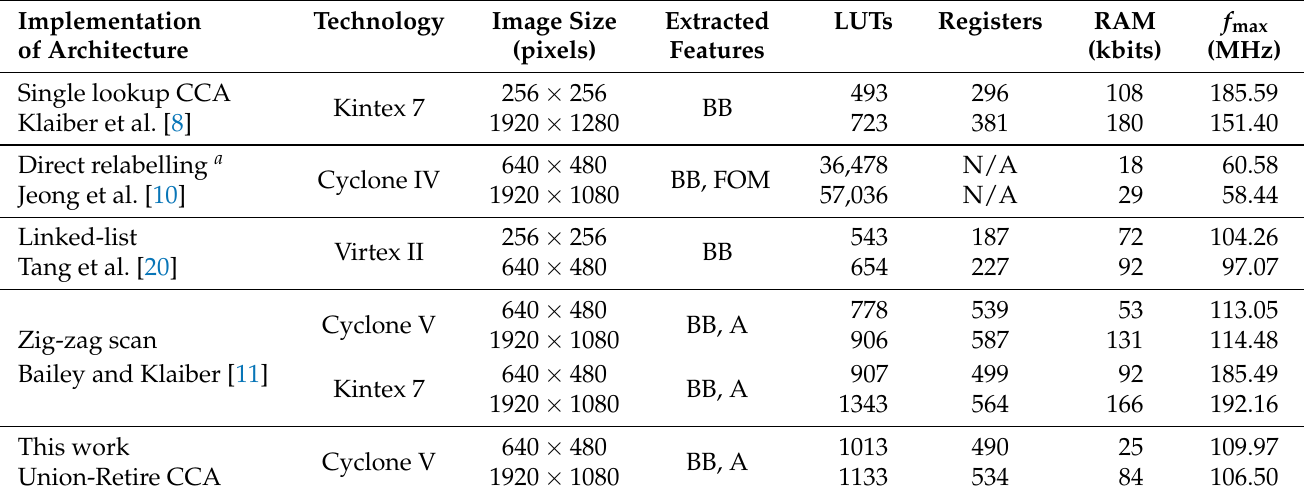
Table 2. Comparison of several CCA hardware architectures. Abbreviations for the extracted feature vector are: (A) area, (FOM) first-order moment, (BB) bounding